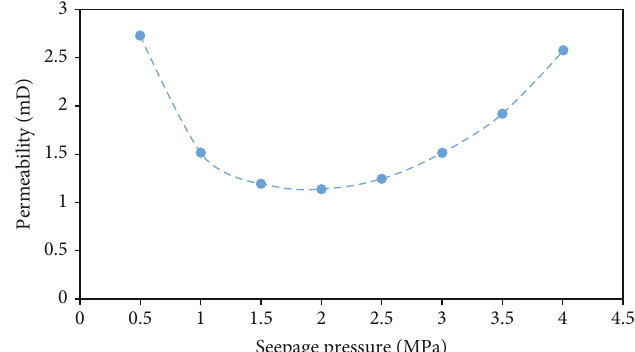
Figure 11: Variation of coal permeability with seepage pressure.